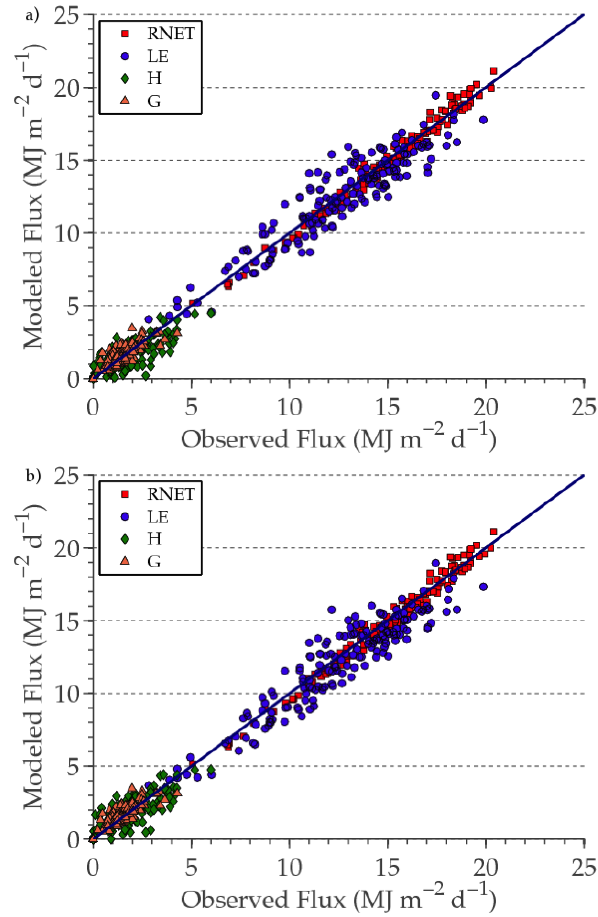
38 Figure 9. Comparison of daily modeled and measured energy bal- ance components for maize and soybean at Mead, NE, using TSEB- LUE with (a) fixed β n and (b) β n as a function of